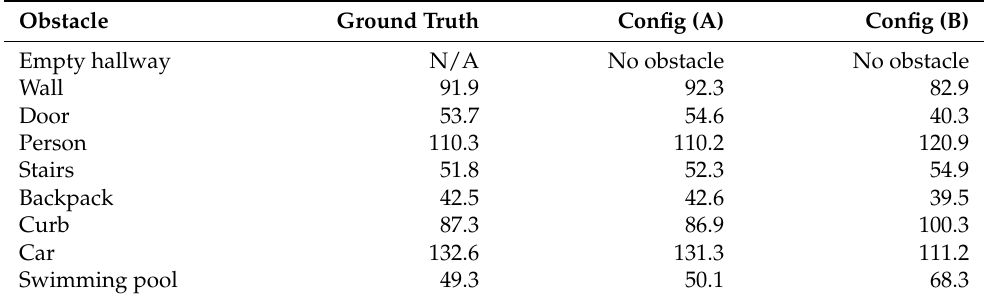
Table 1. Comparing the accuracy of configurations A and B for measuring the distance (cm) to several indoors (upper part) and outdoors (lower part) obstacle